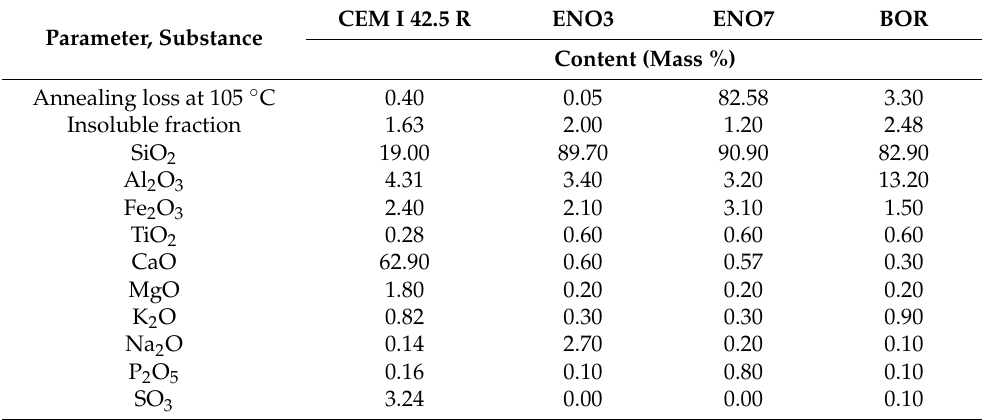
Table 1. Chemical composition of base materials.